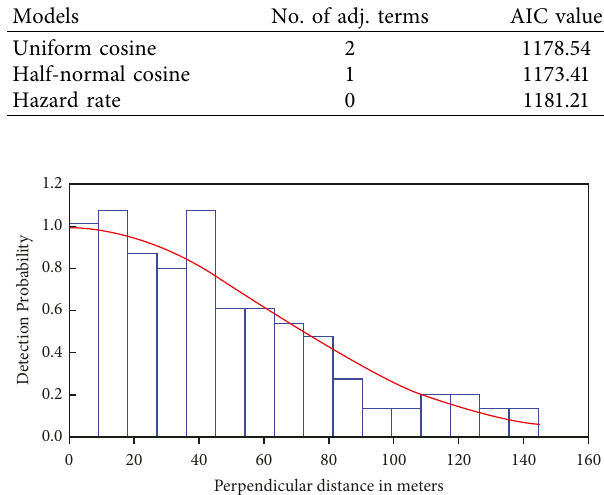
Figure 2: Detection function showing the probability of detecting the defassa waterbuck within the effective strip width